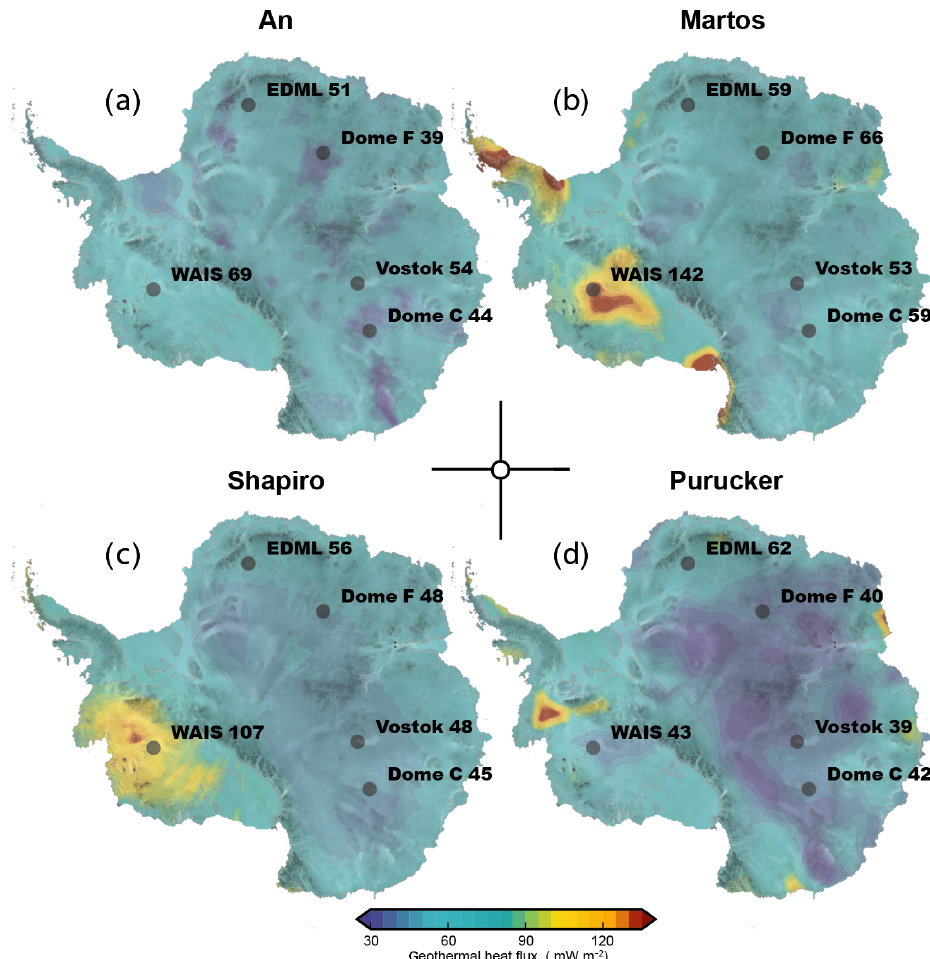
Figure 4. The four panels illustrate the four GHF input data sets (Shapiro and Ritzwoller, 2004; Purucker, 2013; An et al., 2015; Martos et al., 2017) used in this study. As a reference the rounded GHF (in mWm 2 ) at selected ice core locations is provided. Table 2. Selected ISM parameters for the model ensemble. The first and second line show the main parameter sets used in the ensemble (P1 and P2). The third line lists additional parameters tested but not further used and discussed in this study (VP). cH stands for thickness calving limit (in metre); cE is a parameter in the eigencalving equation; sia e and ssa e stand for the so-called SIA and SSA enhancement factors; till min and till max modify basal friction in the sliding law. γ EAIS is a dimensionless scaling factor for basal shelf melt for selected East Antarctic ice-shelf regions (George V Land, Wilkes Land). Parameter changes between P1 and P2 are highlighted in bold. Parameter sia e ssa e cH (m) cE till min till max γ